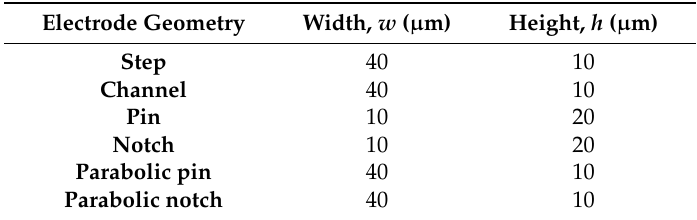
Table 1. Electrode Geometry Parameters.